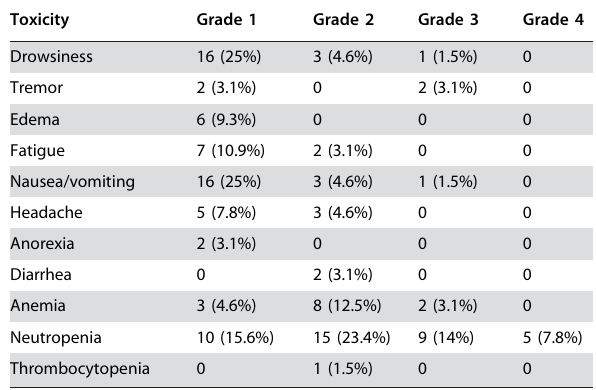
Table 3. Toxicity of treatment from a total of